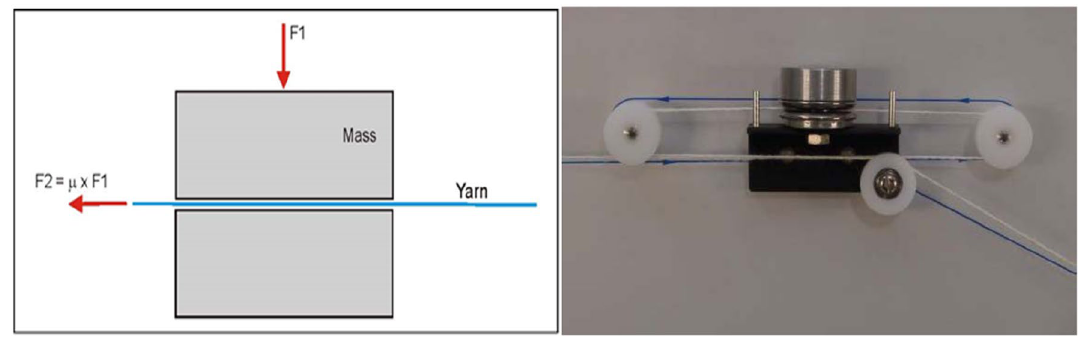
Figure 9. Friction coefficient Tester [Courtesy of EL Sharq El Awsat Co.].